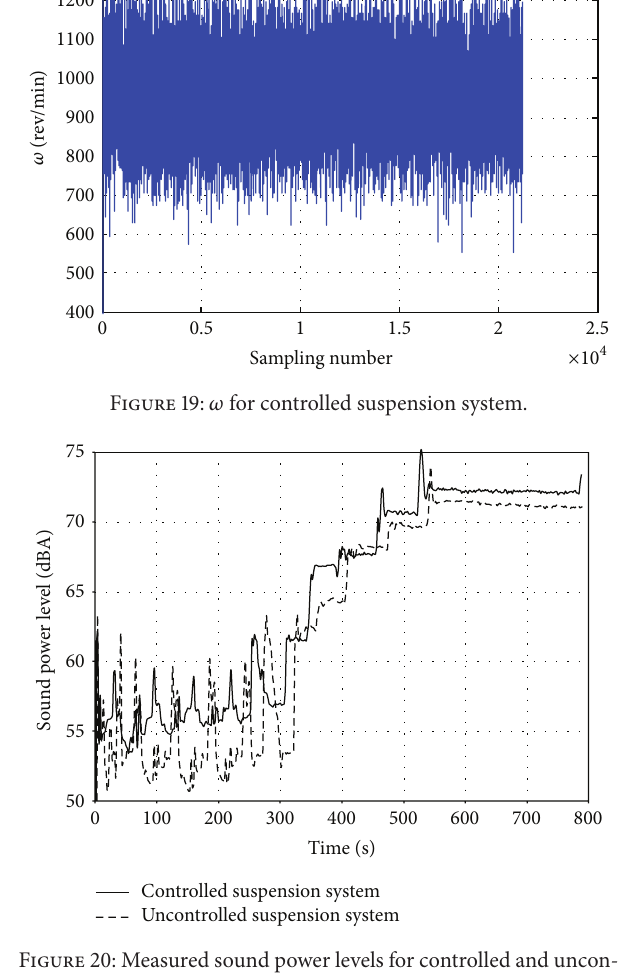
Figure 17: 𝛼 𝑧 for controlled system.